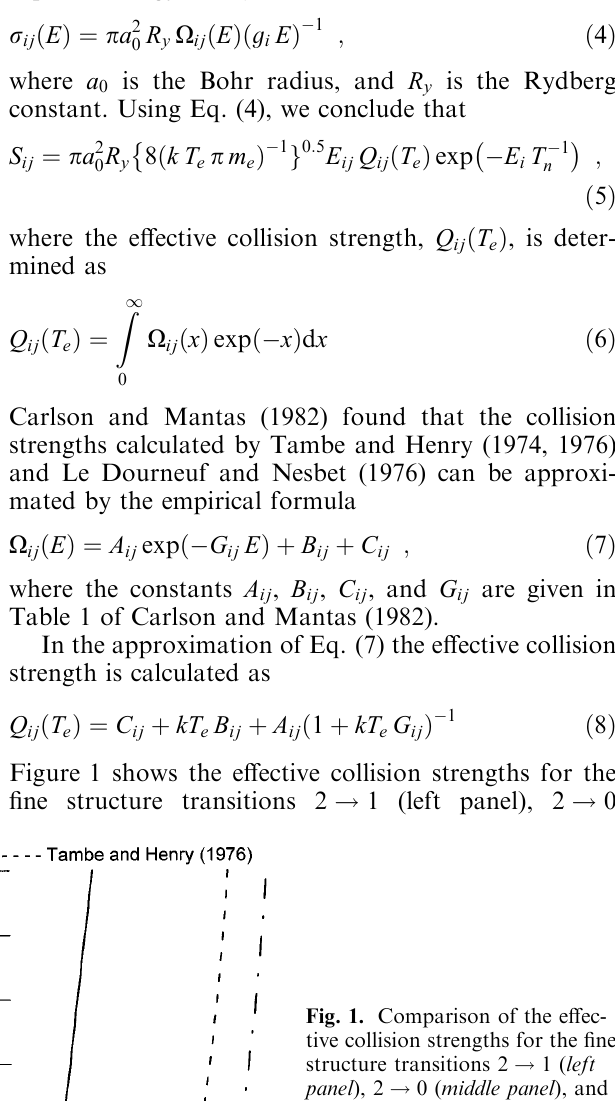
Fig. 1. Comparison of the e(cid:128)ec- tive collision strengths for the fine structure transitions 2 ! 1 ( left panel ), 2 ! 0 ( middle panel ), and 1 ! 0 ( right panel ). Solid lines are Q ji (cid:133) T e (cid:134) calculated by Bell et al. (1998). Dashed-dotted lines and dashed are Q ji (cid:133) T e (cid:134) of Le Dourneuf and Nesbet (1976) and Tambe and Henry (1974, 1976) calculated in the approximation of Eq. (8) with the constants A ji , B ji , C ji and G ji given in Table 1 of Carlson and